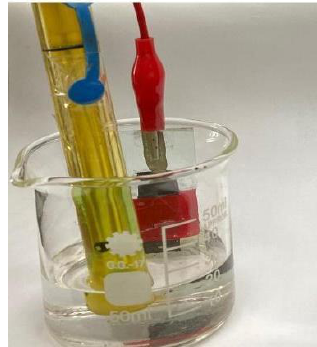
Figure 2. Potentiometric cell assembly with a screen-printed ion-selective membrane sensor for GEMI and a double junction reference electrode.